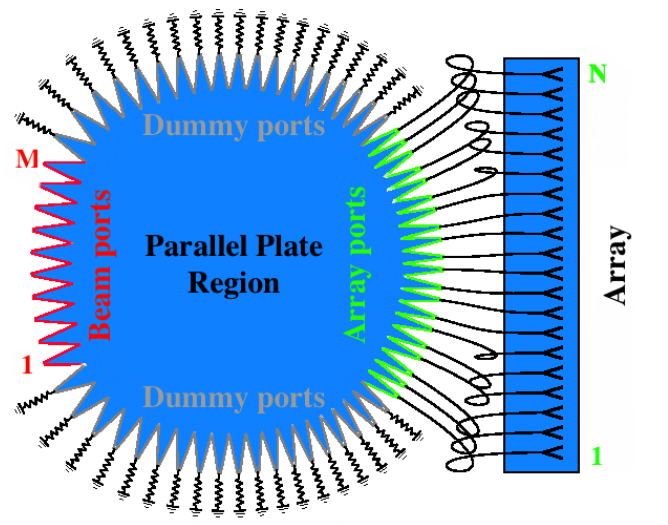
Figure 9. Principle Rotman lens